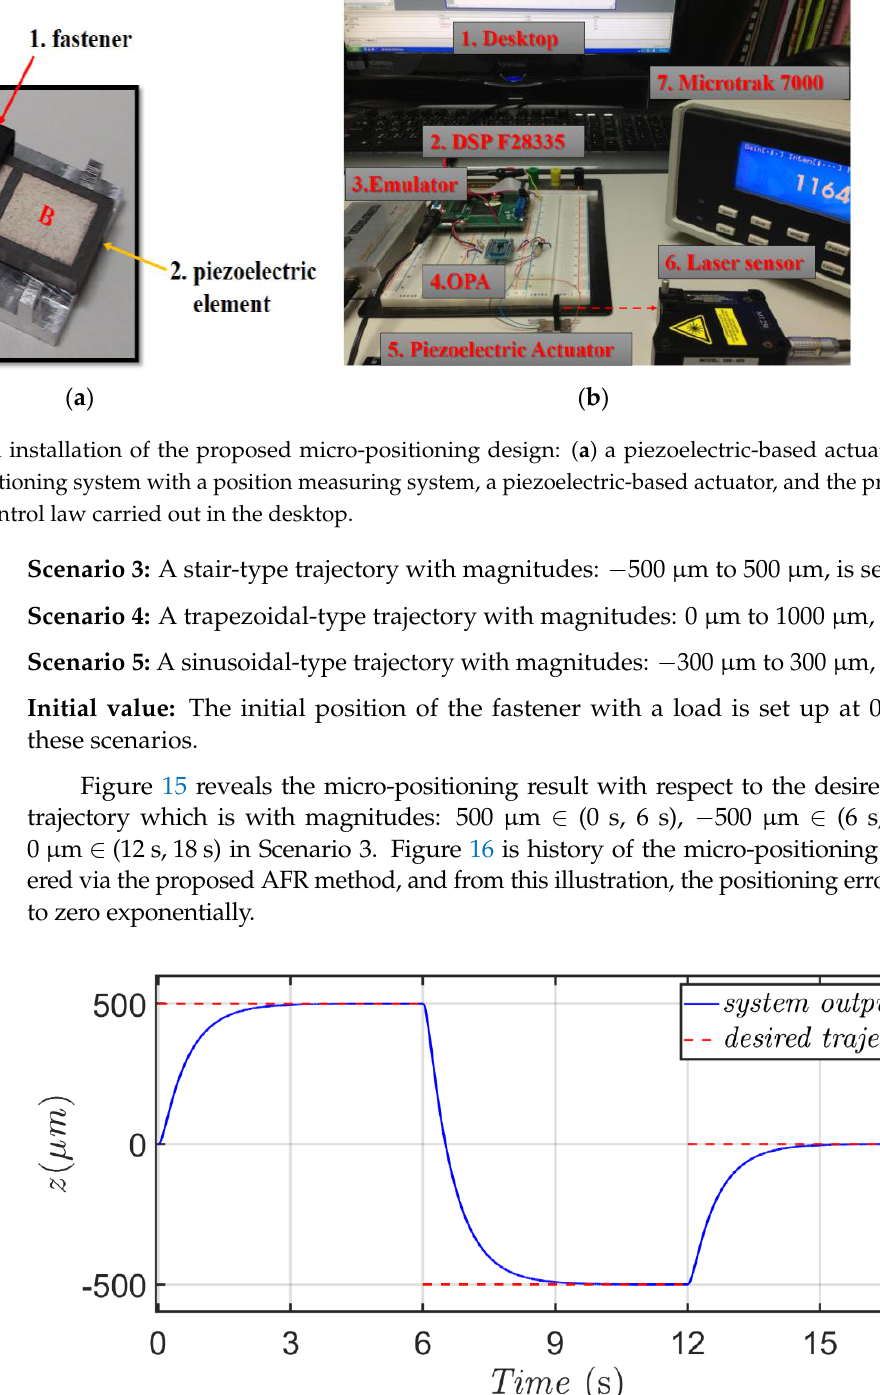
Figure 15. History of the proposed micro-positioning actuator for a desired stair-type trajectory.